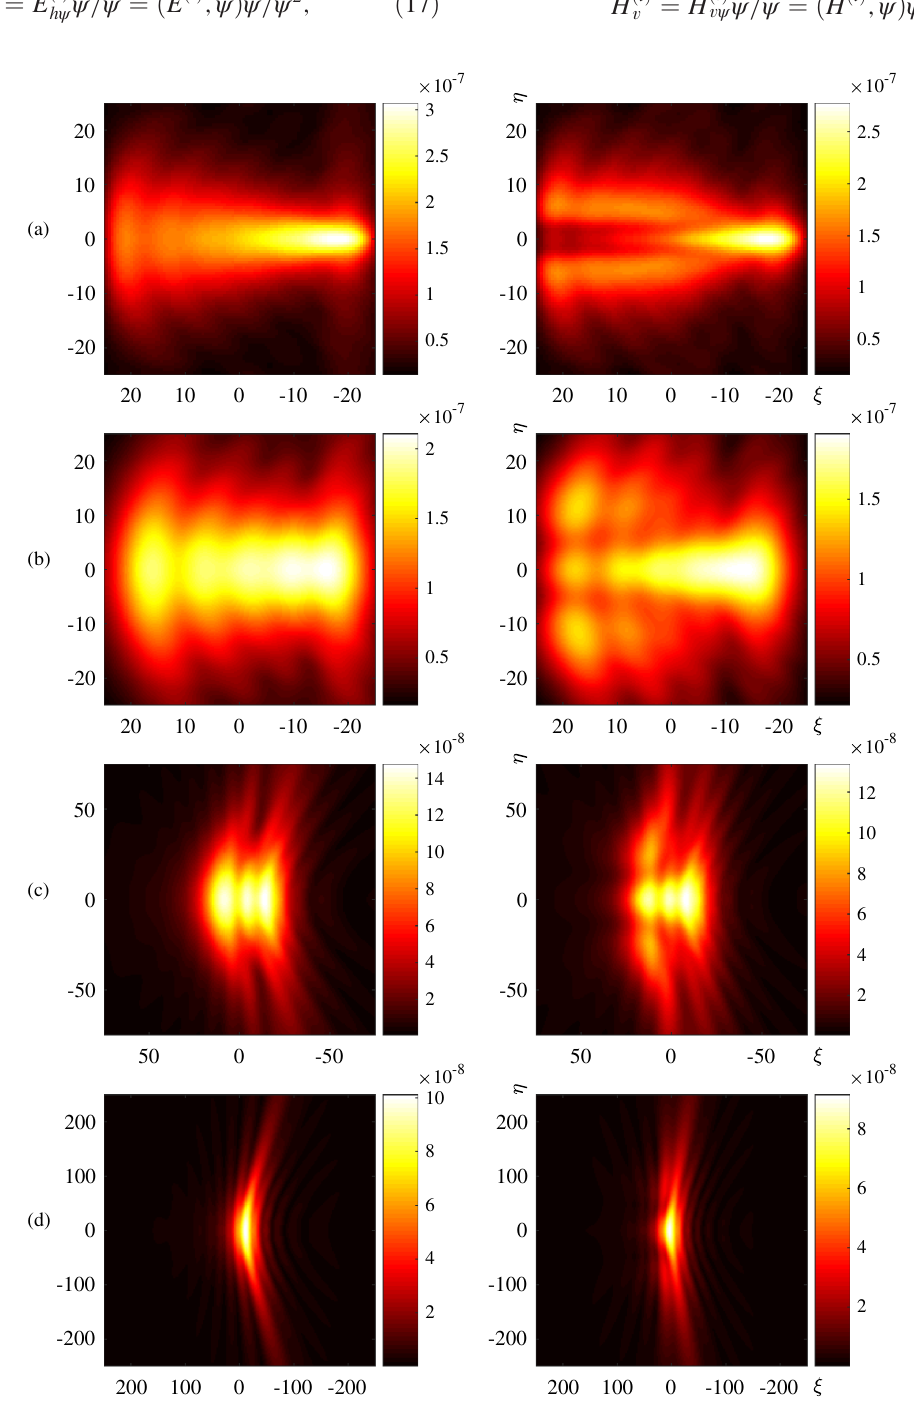
⃗ E FIG. 2. Electric field magnitude j jð V · s = m Þ in the plane ξ , η (parallel to the aperture) for the following parameters: ε ¼ 4 , μ ¼ 1 , d ¼ b ¼ 50 k − 1 , ak ¼ 1 , α ¼ 30 0 , q ¼ 1 nC; β ¼ 0 . 9 (left column) and β ¼ 0 . 999 (right column); (a) ζ ¼ 2 k − 1 , (b) ζ ¼ 10 k − 1 , (c) ζ ¼ 30 k − 1 , and (d) ζ ¼ 100 k − 1